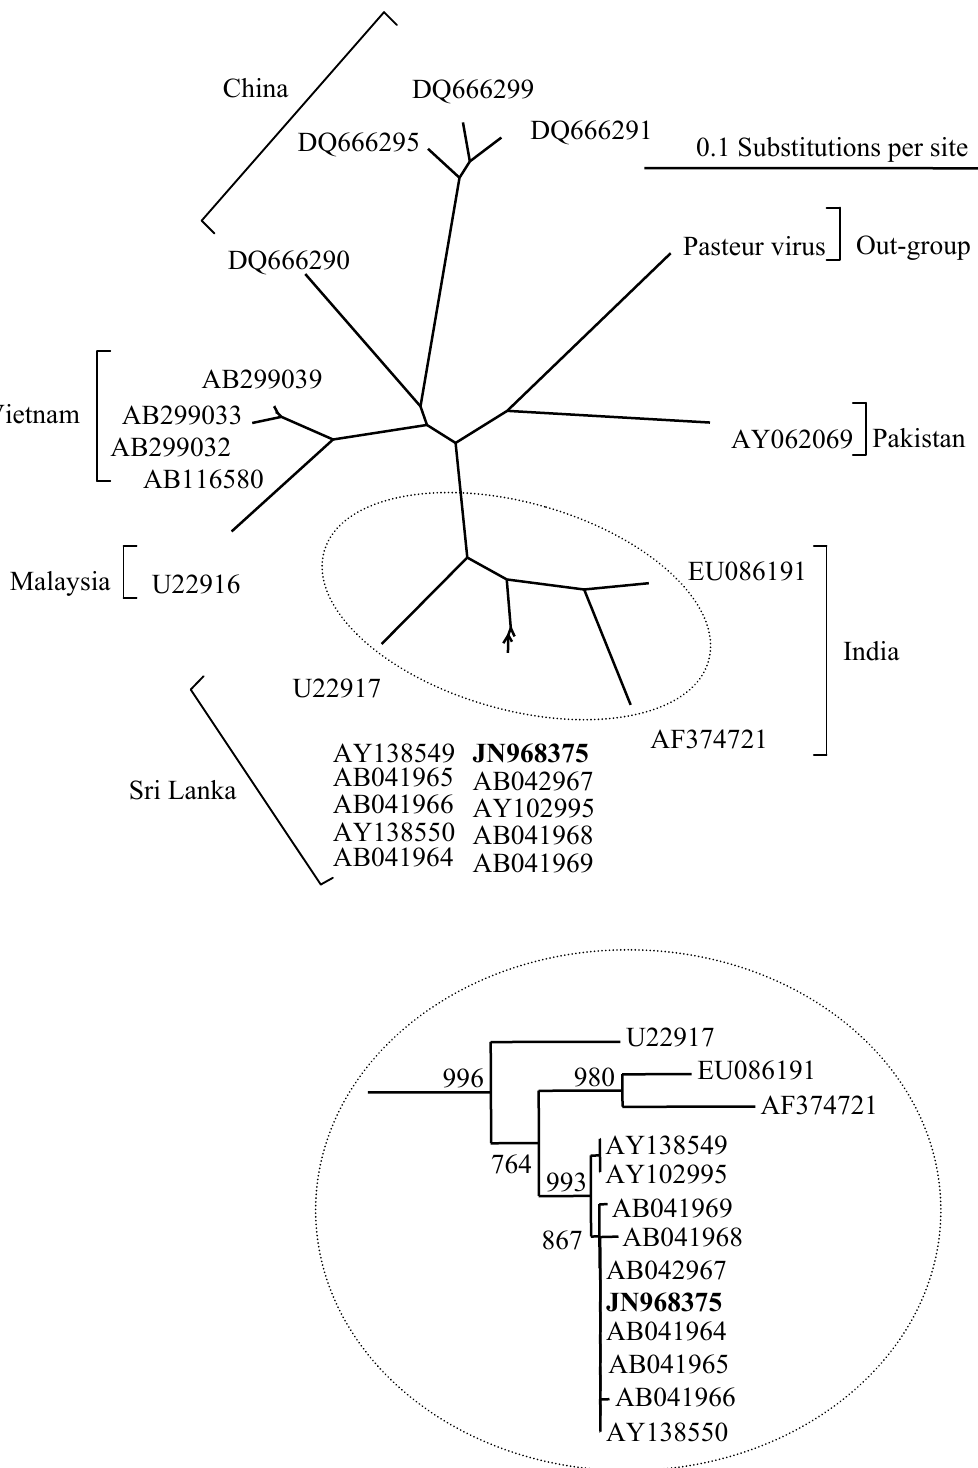
Figure 1. Phylogenetic analysis of rabies virus nucleoprotein sequences (400 bp) of isolates obtained from Asia. The Pasteur virus has been used as an out-group. The sequence from the UK isolate (RV2417) imported from Sri Lanka is shown in bold. Inset shows only isolate sequences from India and Sri